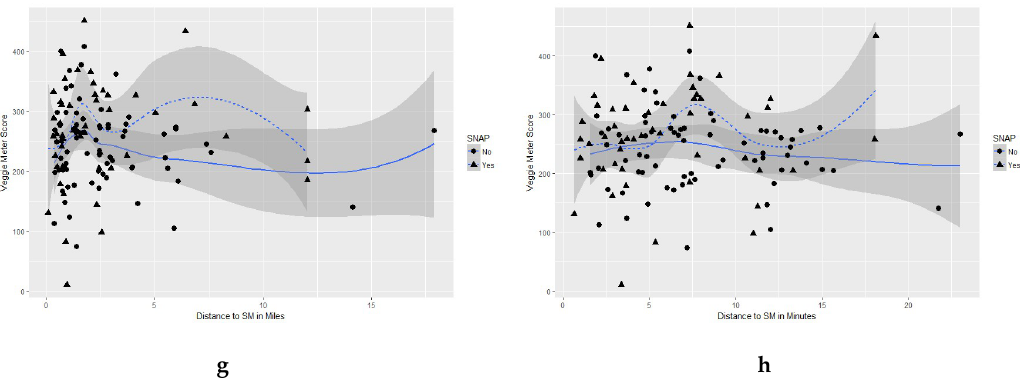
Figure 1. Scatterplots displaying the correlation (with polynomial trend and confidence interval) between skin carotenoid score (mean) and distance to supermarket where surveyed in ( a ) miles and ( b ) min, by store type ( c (miles) , d (min)), WIC ( e (miles) , f (min)) and SNAP ( g (miles) , h (min)).